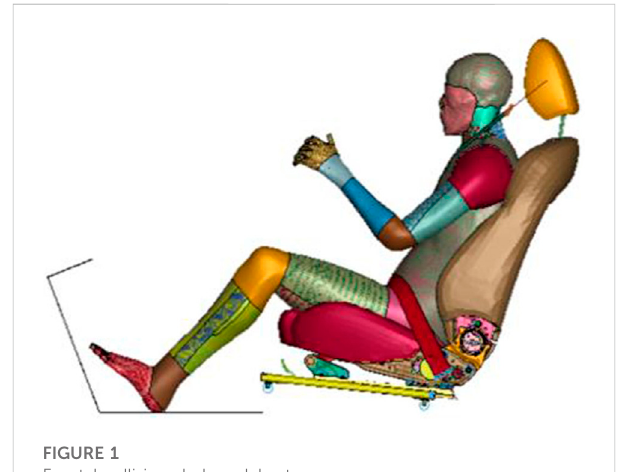
FIGURE 1 Frontal collision sled model